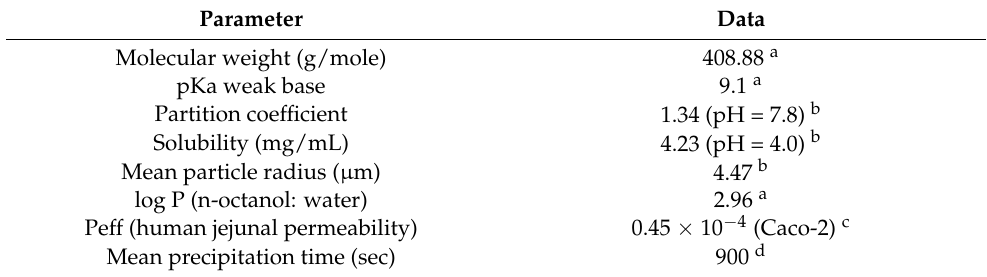
Table 1. Physicochemical and biopharmaceutical properties of amlodipine used in the PBPK models.